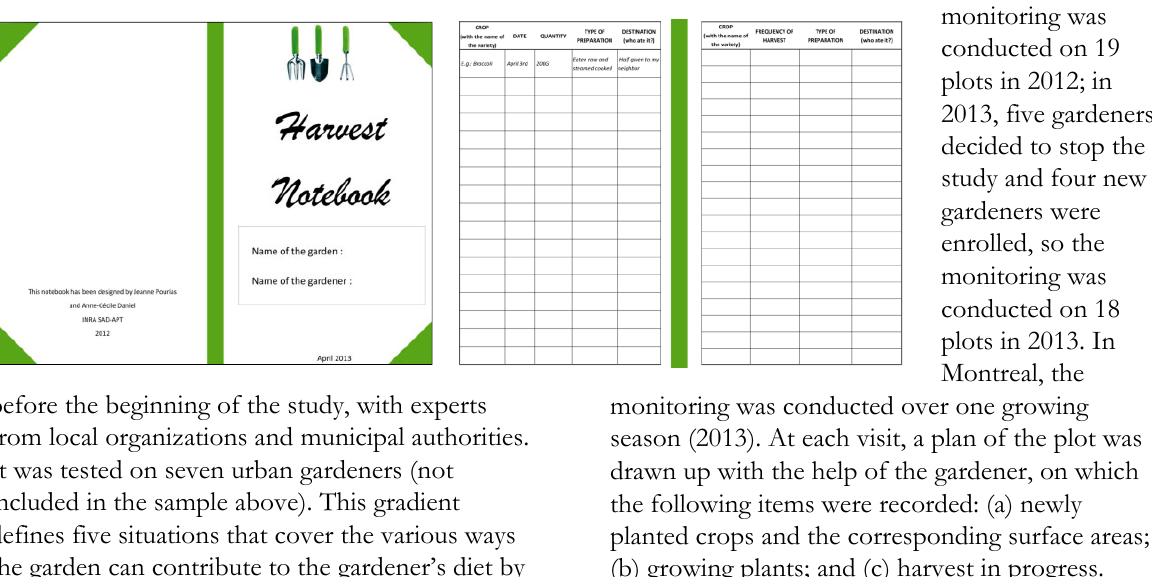
Figure 4. Harvest Booklet: Front and Back Covers and Inside